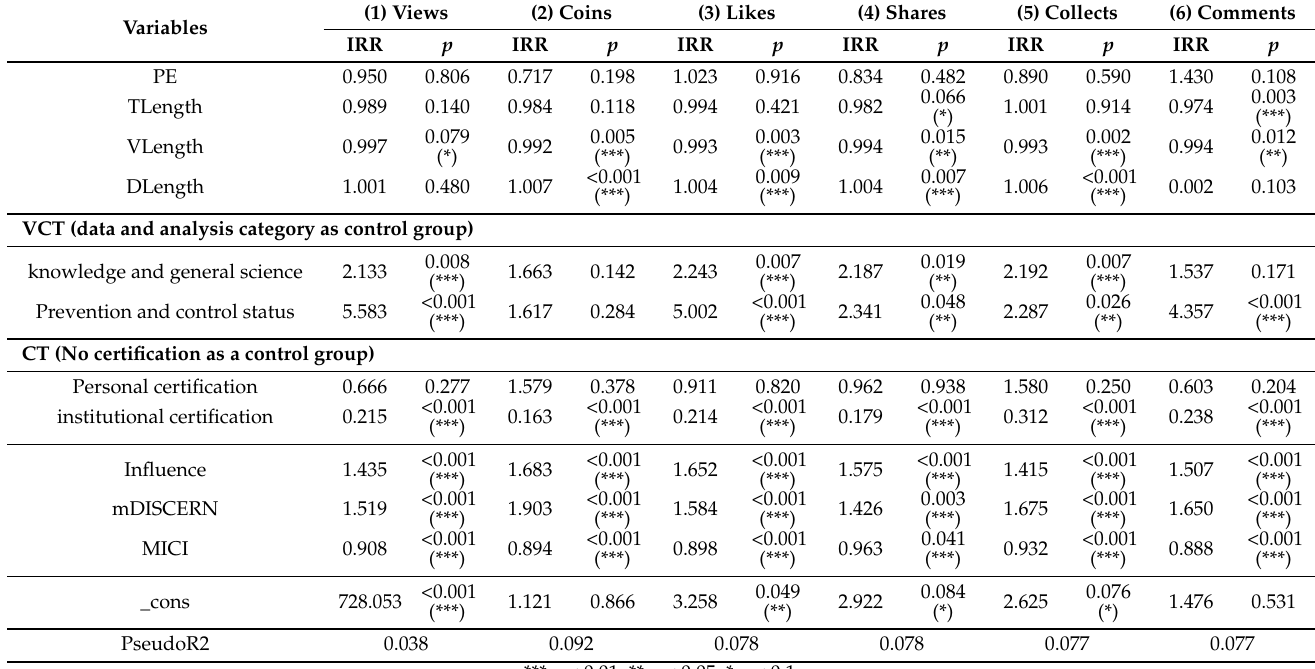
Table 10. Hypothesis